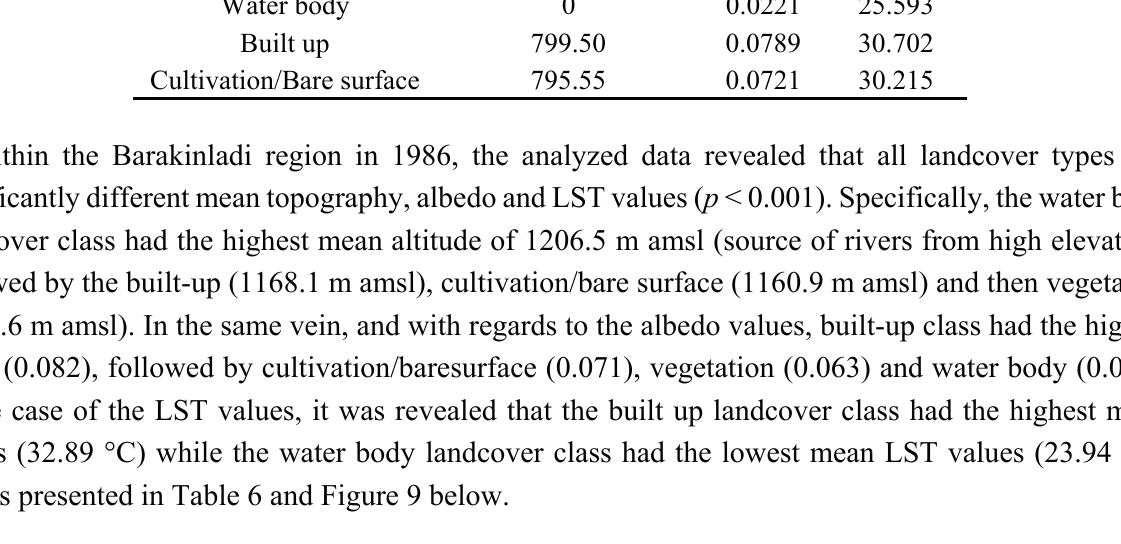
Table 6. Mean topography, mean albedo and mean LST across land cover types in Barakinladi